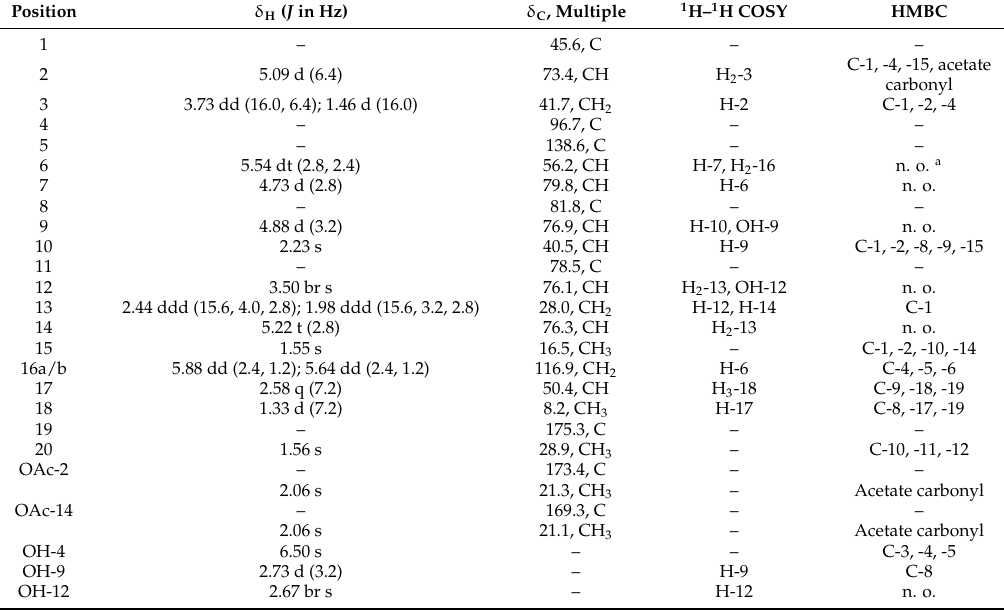
Table 1. 1 H (400 MHz, CDCl 3 ) and 13 C (100 MHz, CDCl 3 ) NMR data and 1 H– 1 H COSY (correlation spectroscopy) and HMBC (heteronuclear multiple bond coherence) correlations for briarane 1 . Position δ H ( J in Hz) δ C ,